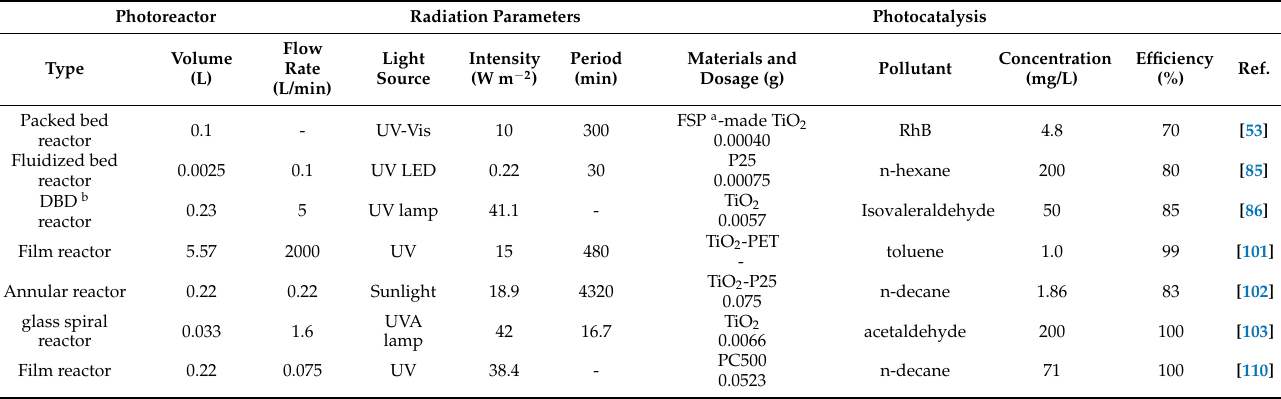
Table 1. Various photoreactors parameters for pollutant